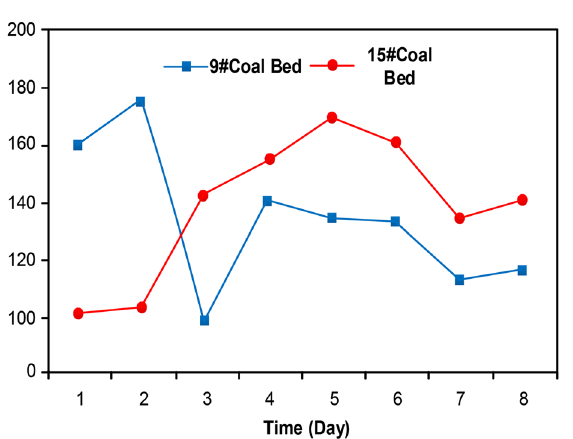
Fig. 10 Unit-thickness gas outputs from different